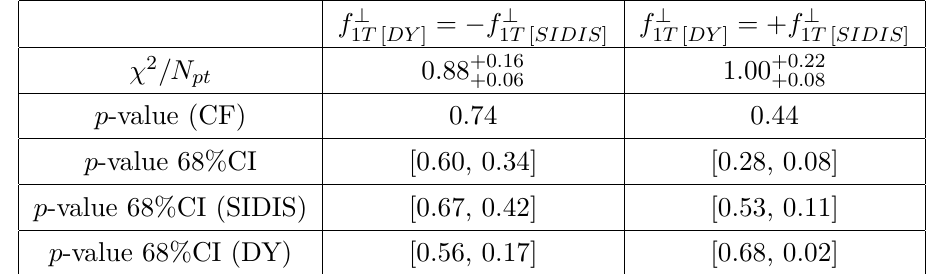
Table 5. Comparison of χ 2 and p -values between the fit with and without sign-change for Sivers